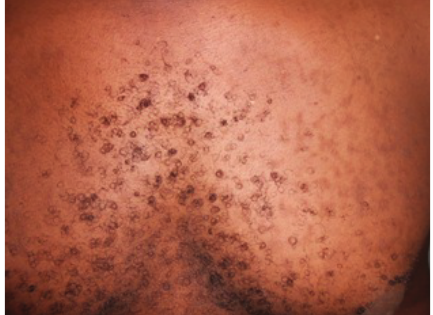
Figure 1: Large losangic placards of the upper back.